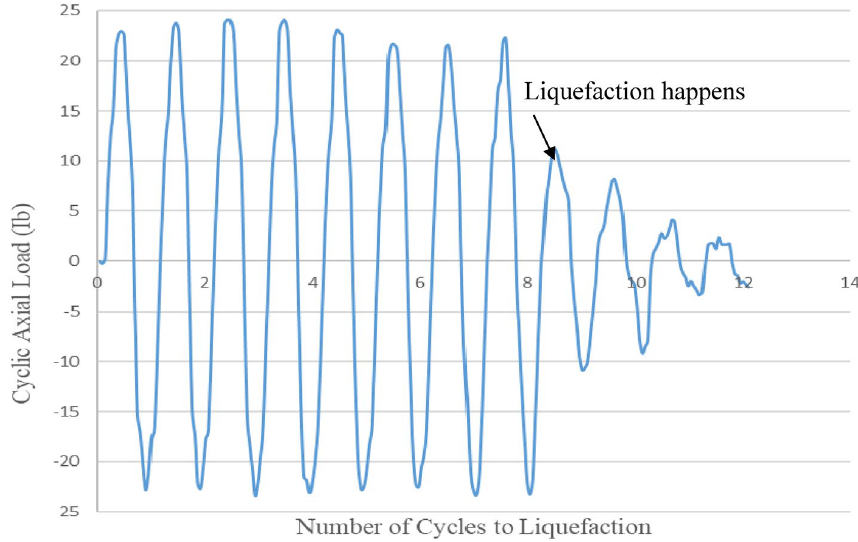
Figure 8. Cyclic axial load versus number of cycles to liquefaction in cyclic triaxial test.